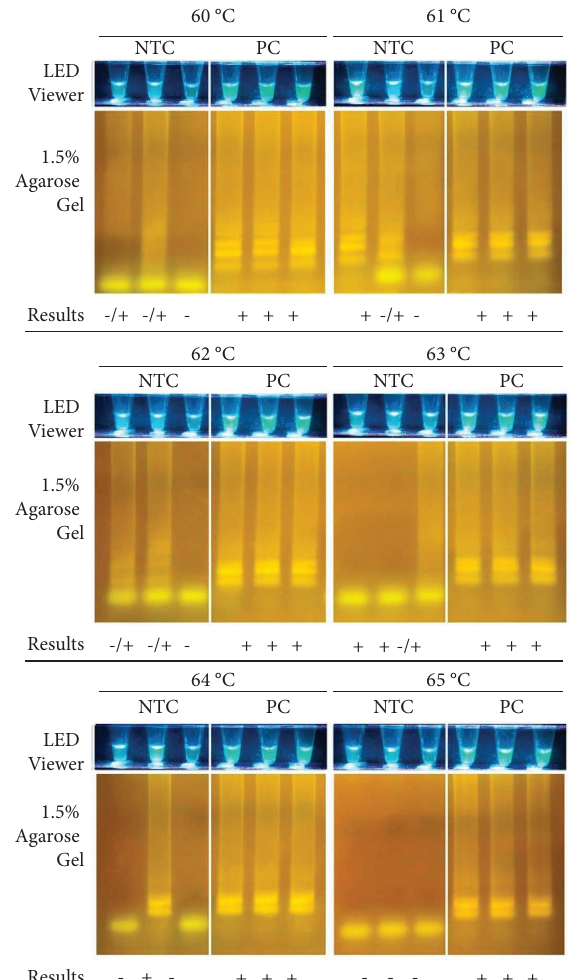
Figure 5: Optimization of assay incubation temperature. Sample (2.5 μ L) was added to 10 μ L reagent mix then incubated at 60–65 ° C for 60 minutes, 80 ° C for 2 minutes, and cooled to 4 ° C for 10 minutes using a T100 Termal Cycler (S/N 621BR14432). Samples used were the No Template Control (NTC) and the Positive Control (PC; 10 6 copies/ μ L). Results were viewed using the EasyView ™ LED Transilluminator (Manila HealthTek, Inc., Marikina, Philippines) which has a blue LED light and a yellow plastic gel flter, and through agarose gel electrophoresis (1.5% agarose, 135V for 25 minutes). Salmonella enterica subsp. enterica positives appear bright yellow green. All images were taken using a Canon EOS 750D camera. Interpretation of results are as follows: (+)–Positive using the LED transilluminator and positive in 1.5% AGE. ( − )–Negative using the LED transilluminator and negative in 1.5% AGE. ( − /+)–Negative using the LED trans- illuminator but positive in 1.5%